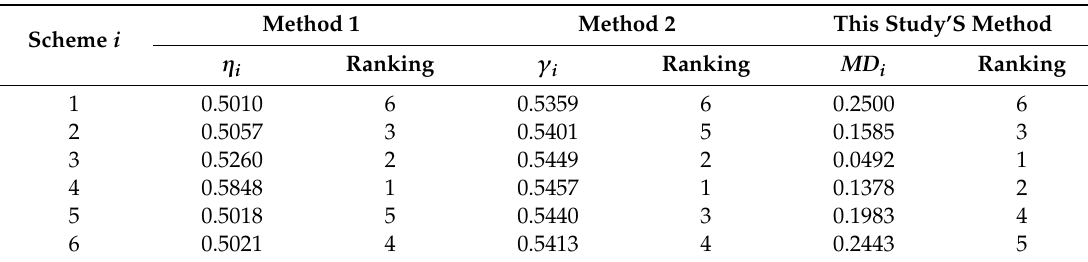
Table 12. Results of scheme ranking.